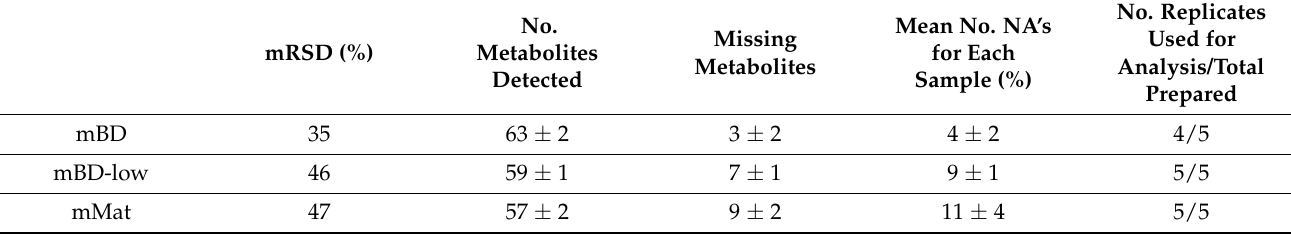
Table 4. Summary of the number of metabolites detected and missing from mouse muscle after